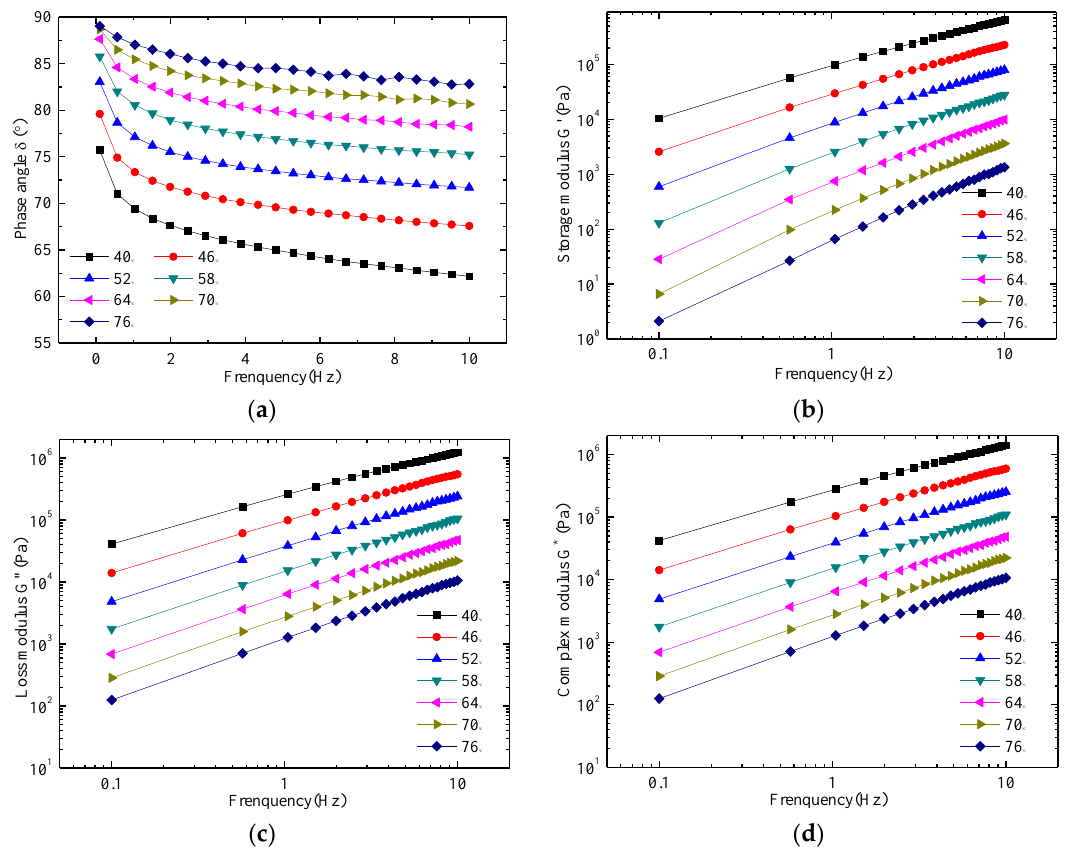
Figure 12. The changes of different parameters of RTFO-aged bio-asphalt with 5% bio-oil content. ( a ) Phase angle; ( b ) Storage modulus; ( c ) Loss modulus; ( d ) Complex modulus.